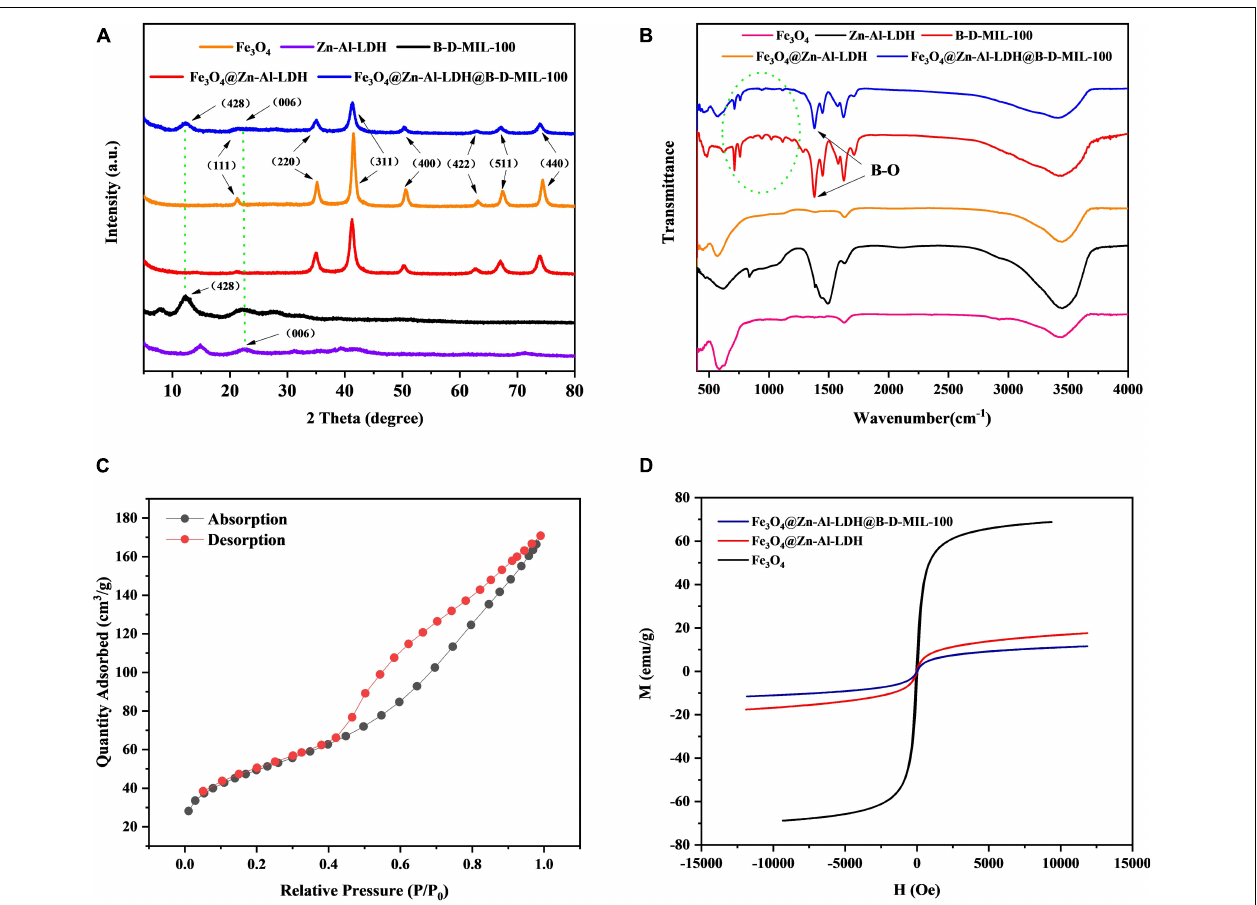
FIGURE 3 | (A) X-ray diffraction, (B) FT-IR, (C) BET, and (D) magnetic characterization of the composites.